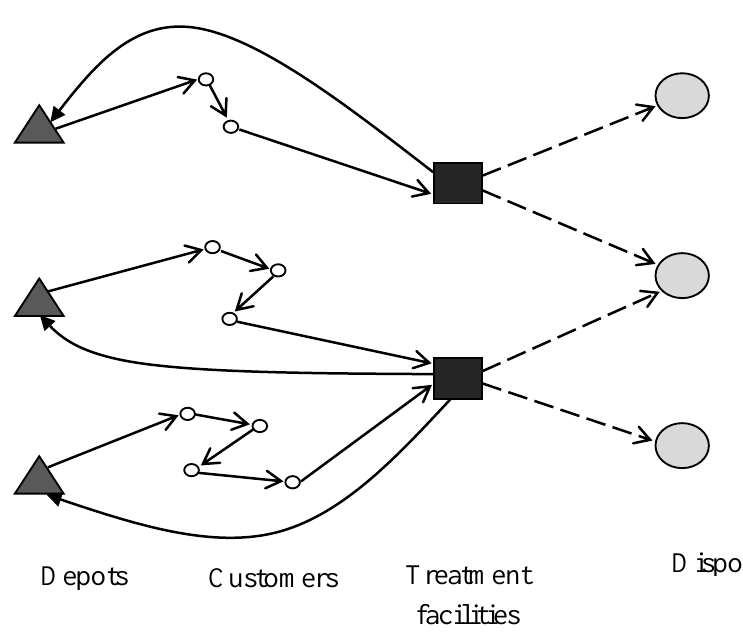
Fig 1 . Example of solution to the